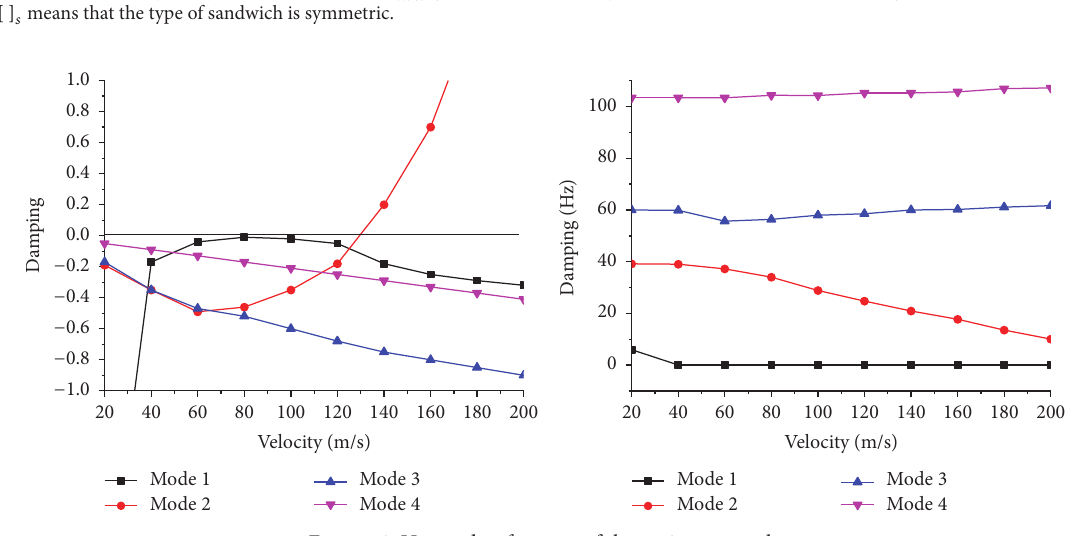
Figure 9: 𝑉 - 𝑔 and V - 𝑓 curves of the optimum